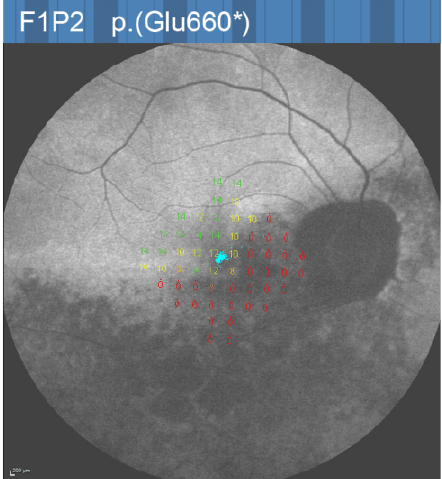
Figure 12. Microperimetry of the female RP patient F1P2 superimposed over corresponding 55° FAF images. Retinal sensitivity of 56 tested loci is represented by a color scale ranging from red (0 dB) to green (20 dB). Fixation points (represented by blue dots) determined a preferred retinal locus. The female patient had sector RP with preserved foveal fixation, while retinal sensitivity was absent only in the areas of RPE atrophy.